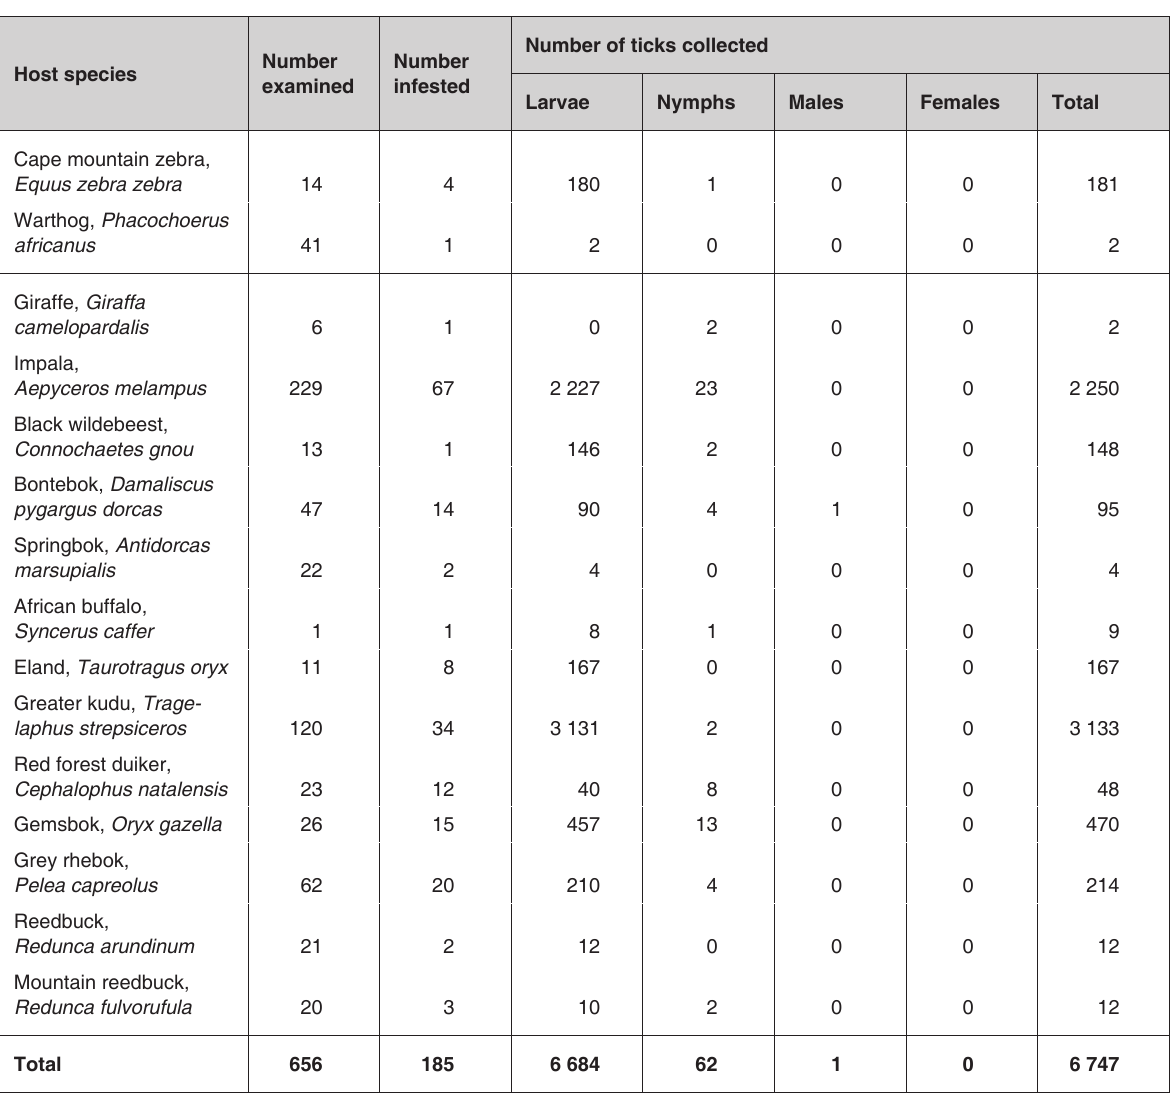
TABLE 5 Amblyomma marmoreum collected from large herbivores